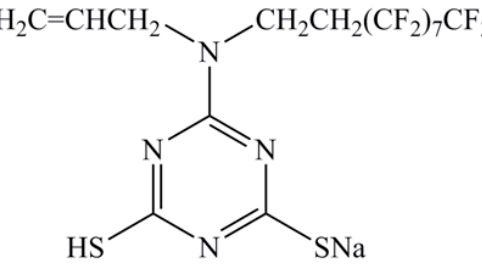
Figure 1. Structure of amino-1,3,5-triazine-2,4-dithiol monosodium (AF17N).